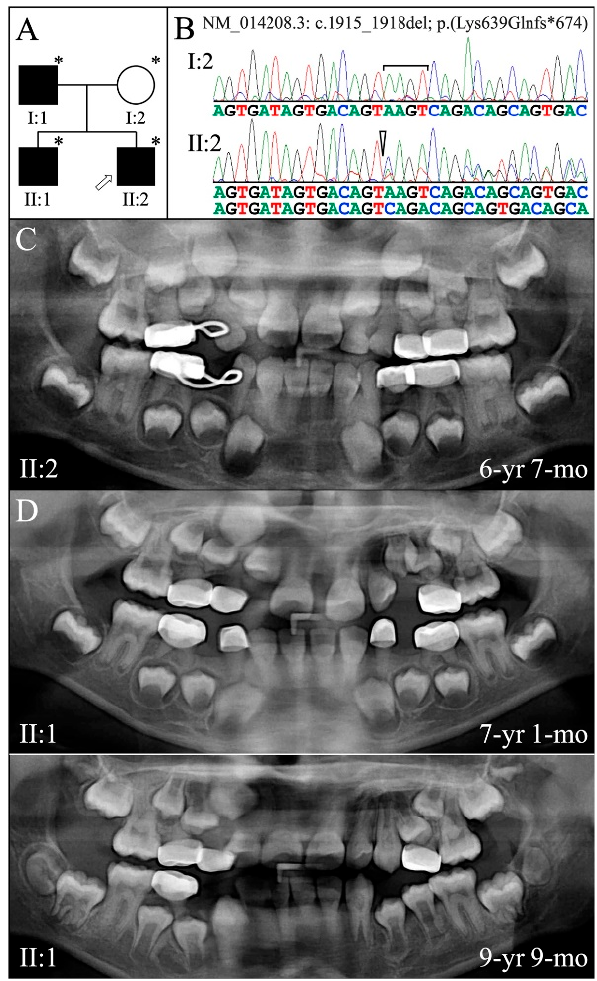
Figure 8. Family 5 from Taiwan. ( A ): Pedigree showing a dominant pattern of inheritance. Panorex radiographs from the affected offspring (II:1 and II:2) showed the remaining primary teeth were more affected than the permanent dentition. ( B ): Chromatogram showing c.1915_1918del. ( C ): Proband ′ s radiograph at age 6 years 7 months. ( D ): Subject II:1 radiograph from age 7 years 1 month and 9 years 9 months. Key : * denotes enrolled participants.